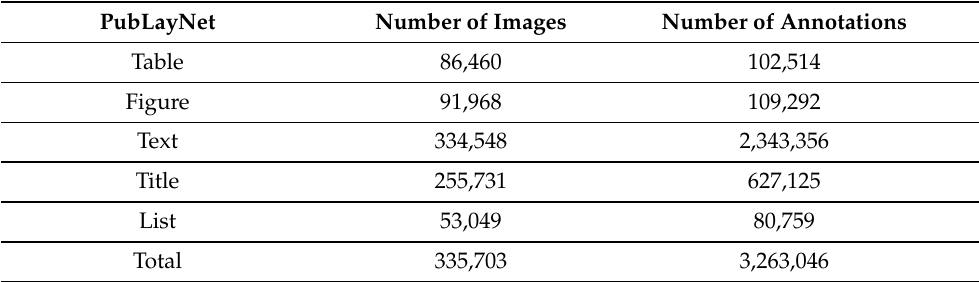
Table 1. Label-wise summary of PubLayNet training dataset.